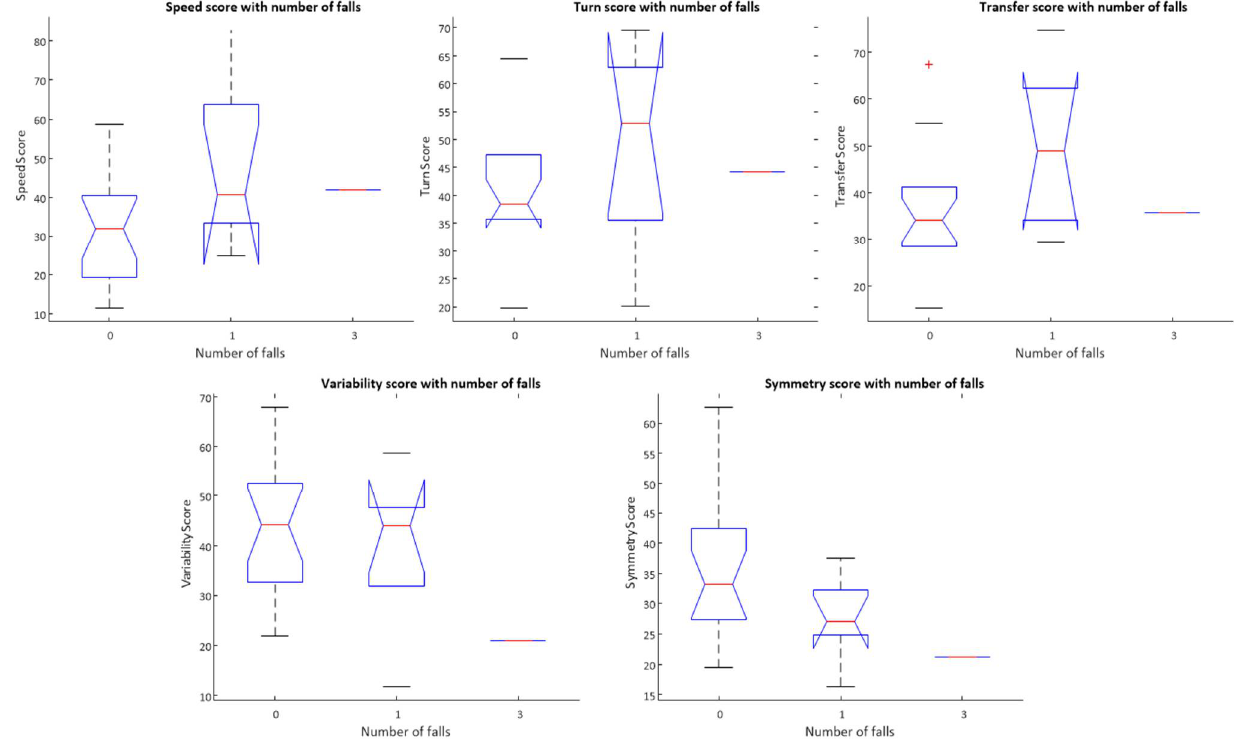
Figure A1. Association of mobility risk scores with number of falls for PD2 dataset. Boxplots for each mobility score are shown (Top row: Speed score, Turn score, Transfer score; Bottom row: Variability score, Symmetry score).